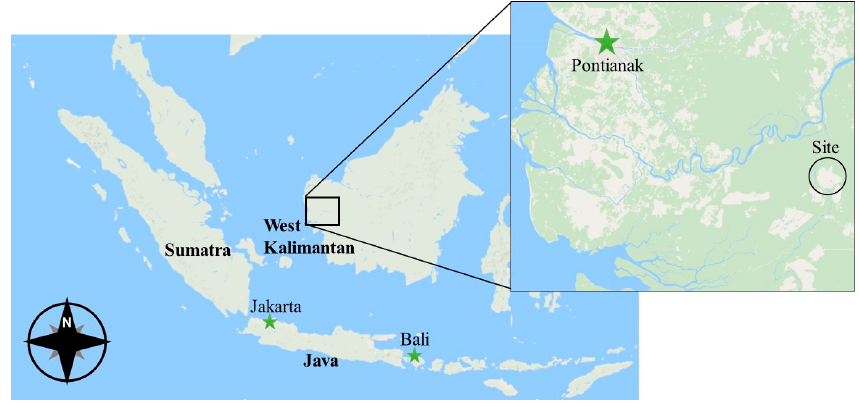
Figure 1. Location of the study site.